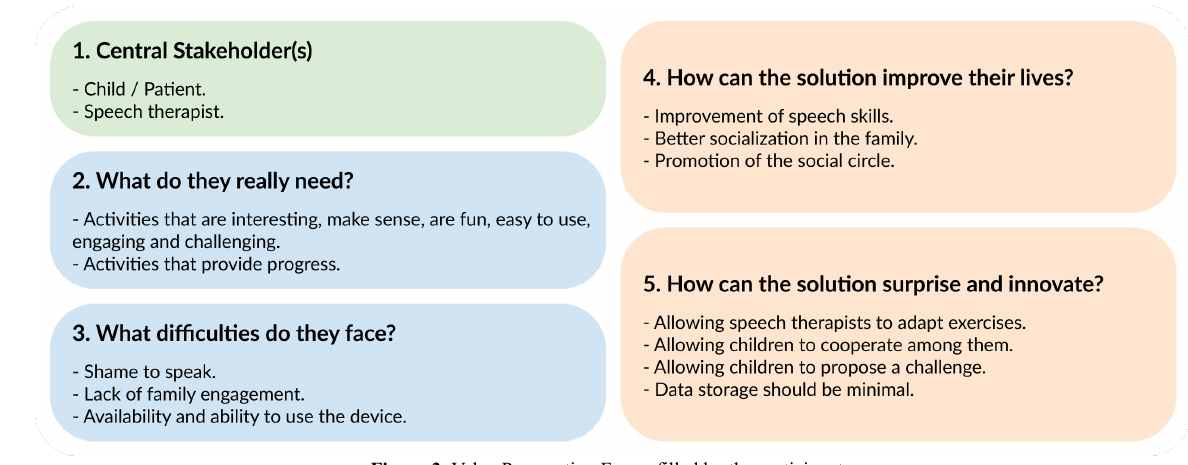
Figure 3. Value Prospecting Frame filled by the